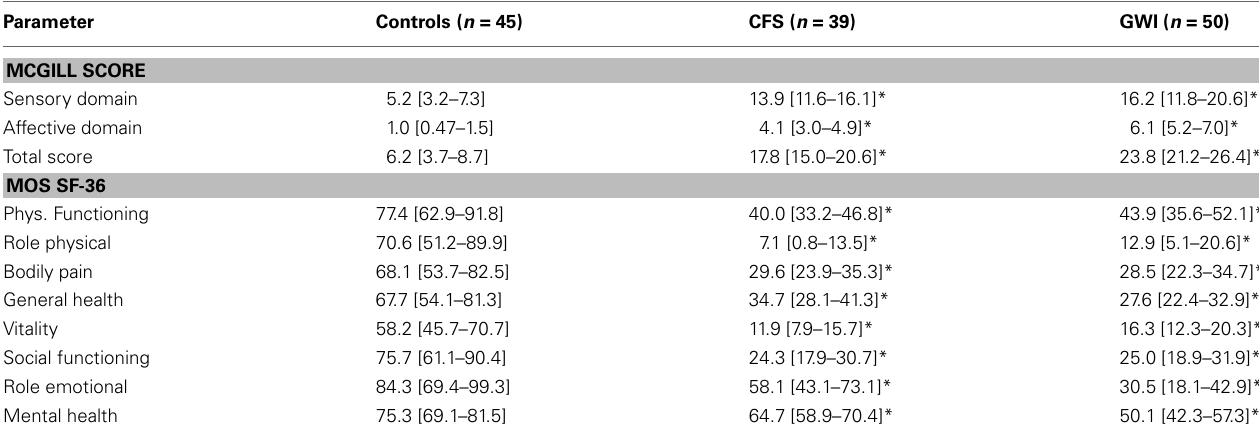
Table 4 | McGill pain and SF-36